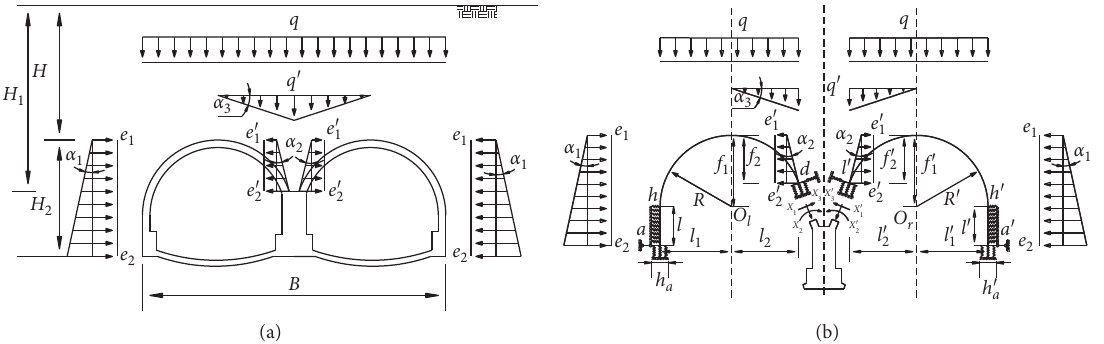
Figure 1: The model of double-arched tunnel: (a) the mechanical model; (b) the simplified mechanical model (explanations for each symbol are allied with the first place it appears in the paper).